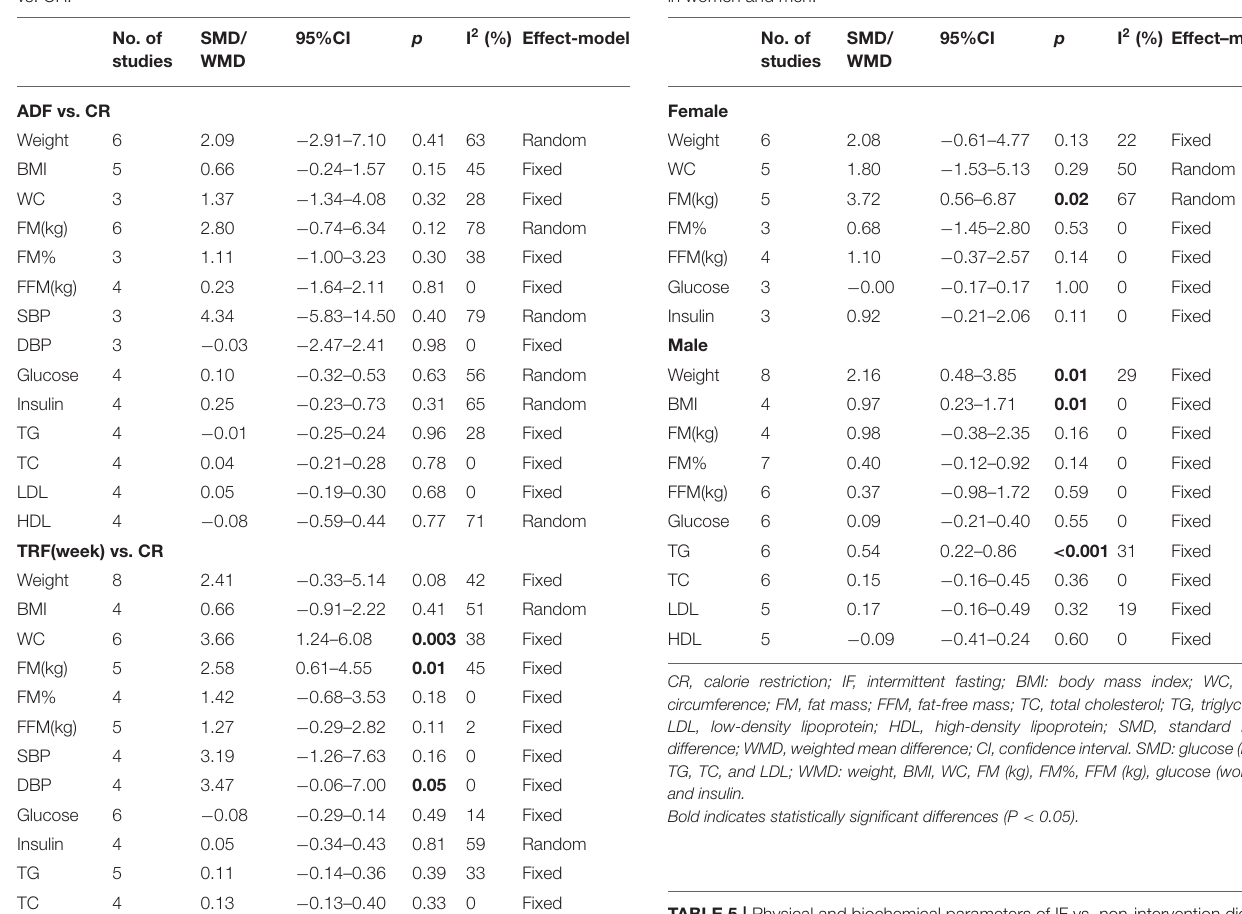
TABLE 5 | Physical and biochemical parameters of IF vs. non-intervention diet in patients with BMI ≥ 25 kg/m 2